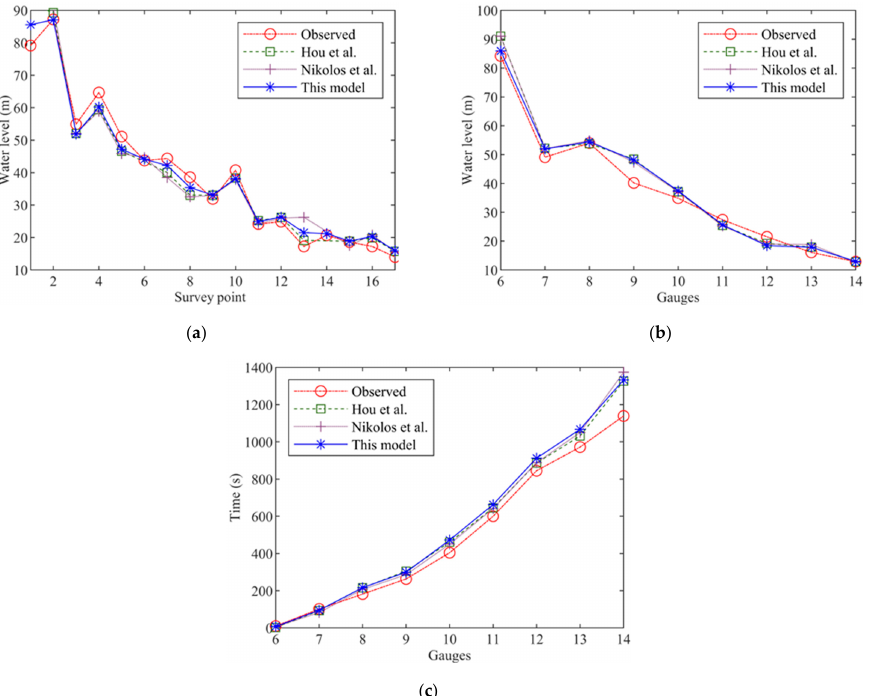
Figure 17. Malpasset dam break: comparison of numerical simulation results with observed and experimental results: ( a ) Maximum water level (survey points); ( b ) Maximum water level (scale model measurements); and ( c ) Wave arrival time (scale model measurements) [33,42].